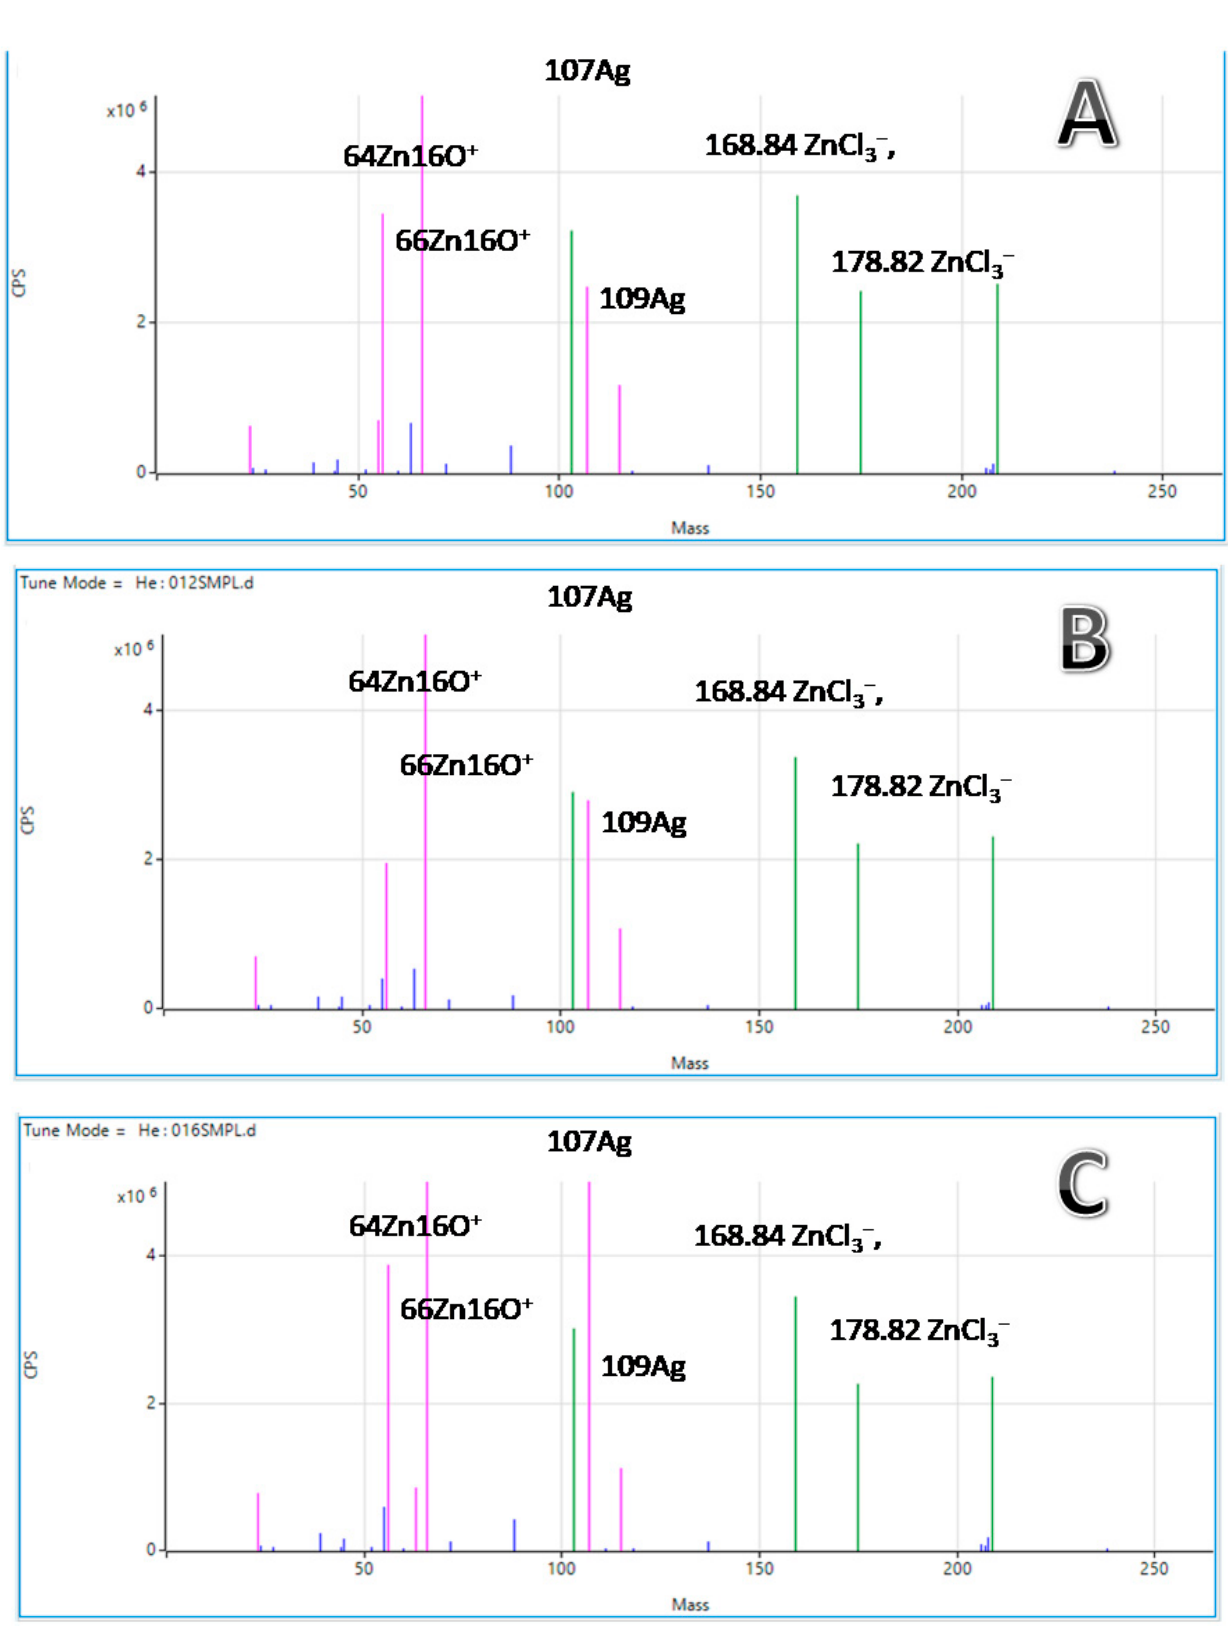
Figure 7. ICP-MS spectra used for determination of the concentration of Ag (107) and Zn (64): ( A ) 120 μ m microcapsules prepared without chitosan, ( B ) 450 μ m microcapsules prepared without